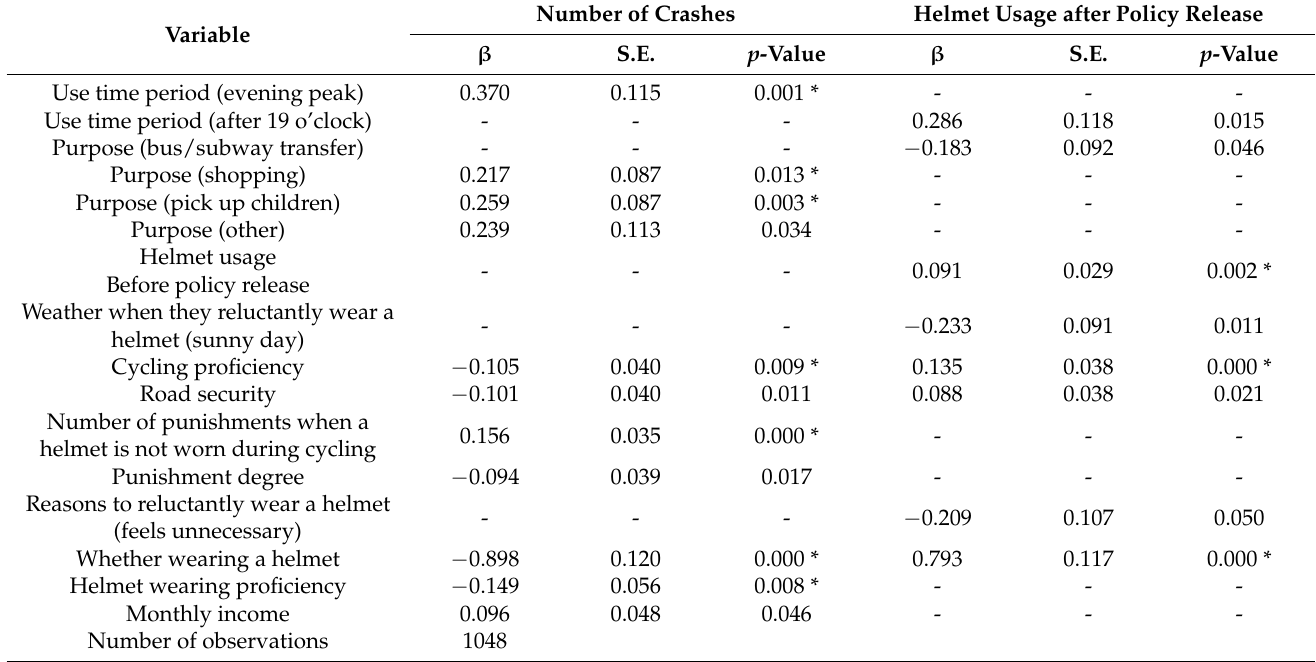
Table 5. Estimated results of the BOP model.